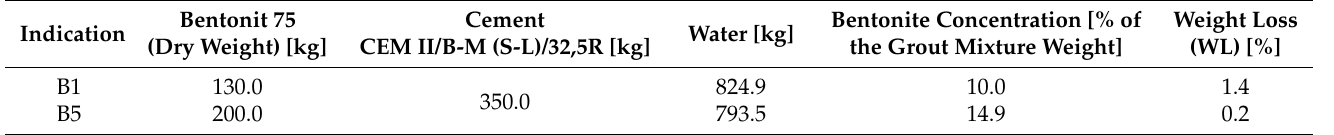
Table 3. Composition * and WL of grout mixtures based on Bentonit 75.